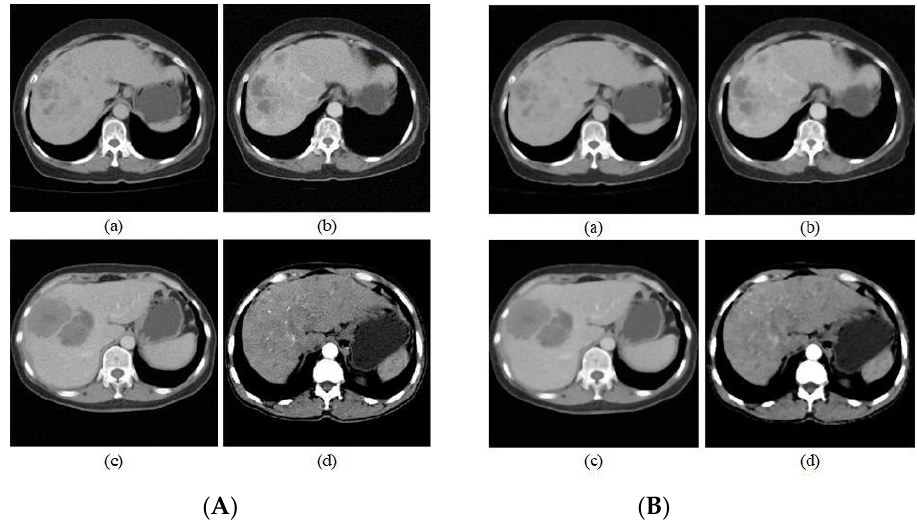
Figure 3. ( A ) Partial liver CT pictures before denoising; ( B ) Partial liver CT pictures after denoising.